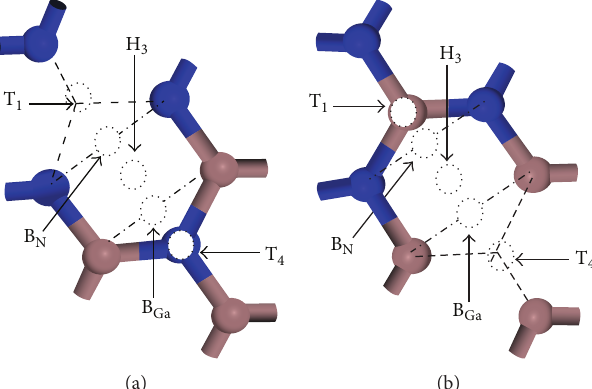
Figure 2: Top view of various possible adsorption sites of Cs on 2 × 2 GaN(0001) defect surface: (a) Cs on Ga defect surface, (b) Cs on N defect